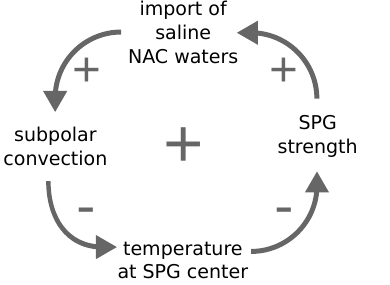
Fig. 3. The feedback loop that leads to the self-amplification of the SPG transport as described in the text. The stronger SPG imports more warm and saline water from the North Atlantic Current; thus increasing the surface salinity in the subpolar region, which fos- ters winter convection and thereby leads to lower temperatures at the SPG centre. Thus increasing the centre-rim density contrast and thus geostrophic SPG transport.